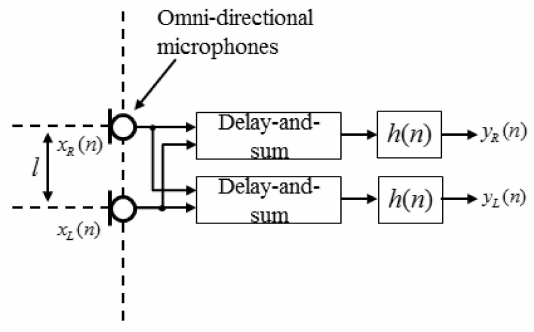
Figure 1. Block diagram of a conventional stereophonic image enhancement